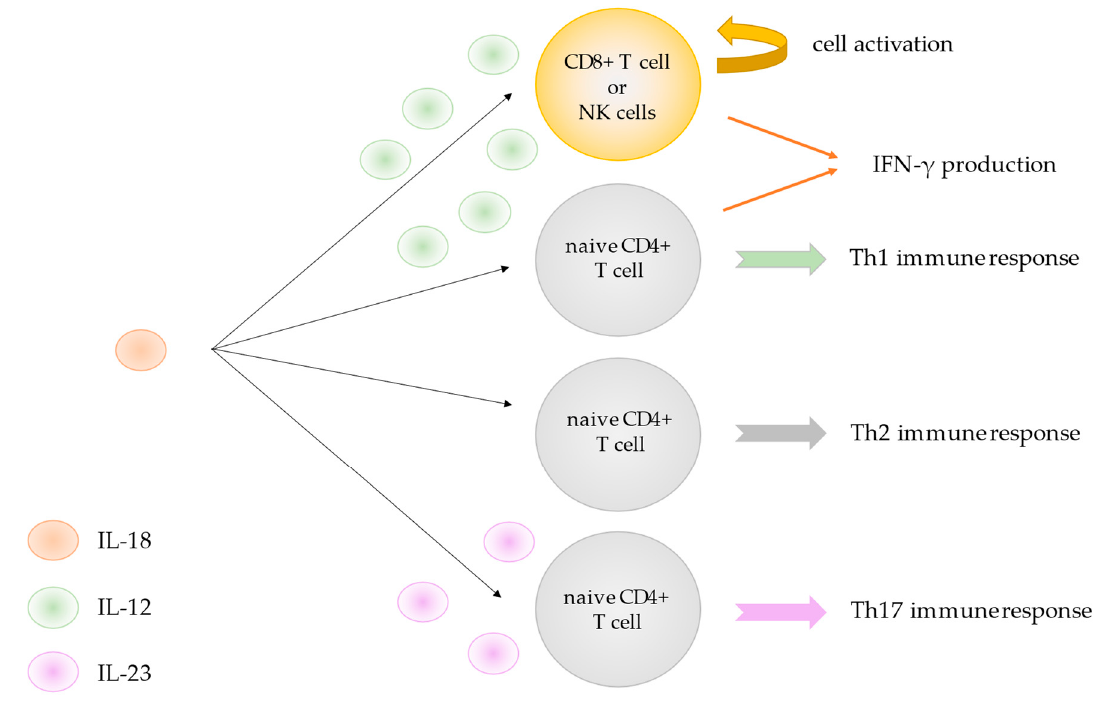
Figure 1. IL-18 functions depending on cytokine environment. IL : Interleukin; CD : cluster of differentiation; NK : natural killer; IFN : interferon. Th : T helper.